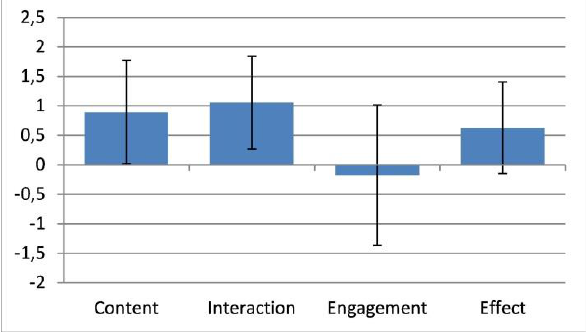
Figure 4. Results of the pilot